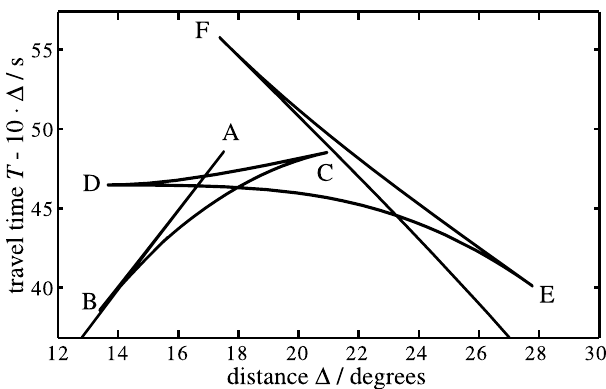
Fig. 1. Observed waveforms and nominal ray paths of regional P -waves, for a magnitude 6.4 earthquake off the coast of Mexico (2008/09/24 02:33:05, Lat: 17.61 Lon: -105.50, Depth: 6 km). The ray coloring in left figure corresponds to the coloring of the waveform clusters in right figure. Our automated clustering algorithm sorts the different kinds of triplicated phases into different groups, based on the dissimilarity of the broadband waveforms. The waveform below each seismogram group is the waveform stack. The groups coincide with the epicentral distance bins predicted by theory (see text for details). This demonstrates that we are dealing with a robust signal that waveform tomography should be able to interpret.